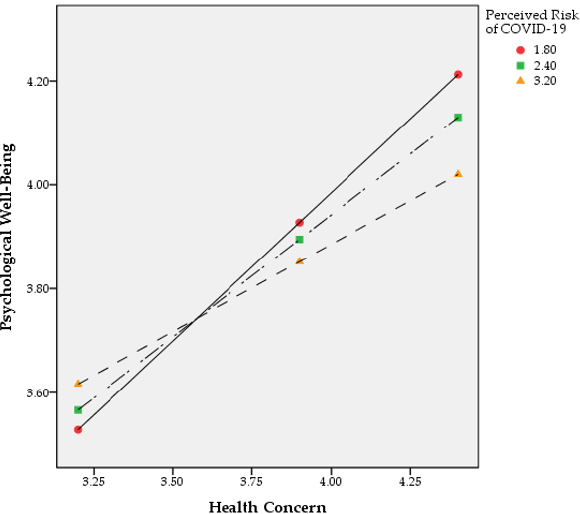
Figure 2. Moderating effect of COVID-19 perceived risk on the relationship between health concern and psychological well-being.